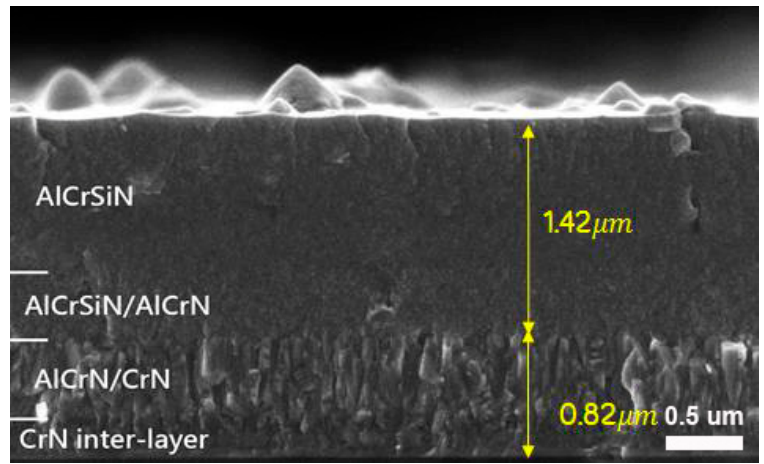
Figure 3. Cross-sectional SEM image of AlCrSiN coating.